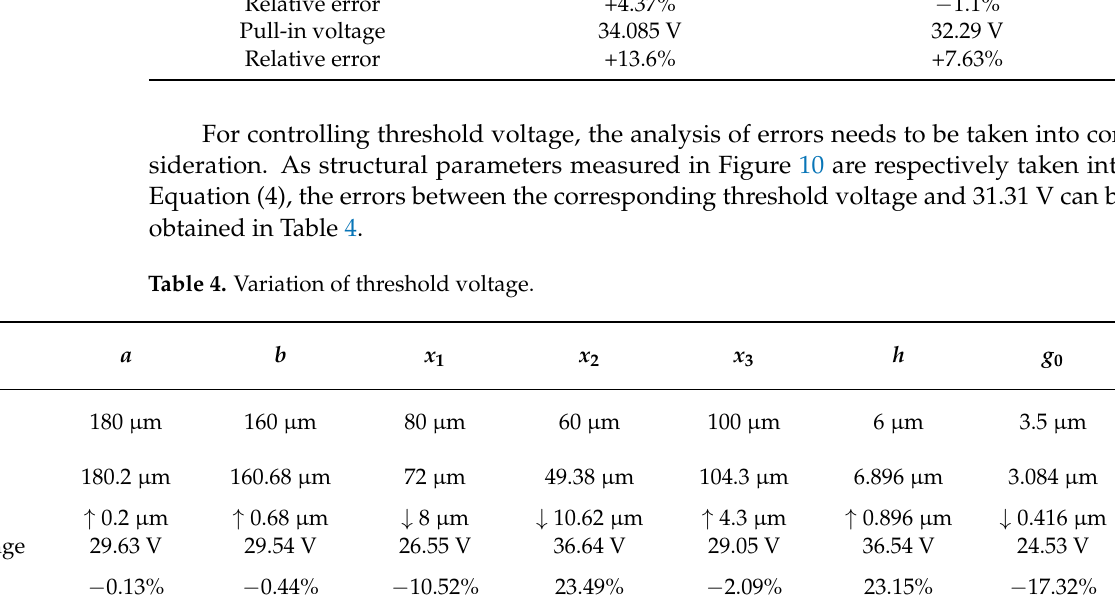
Table 3. Variation of threshold voltage and pull-in voltage.